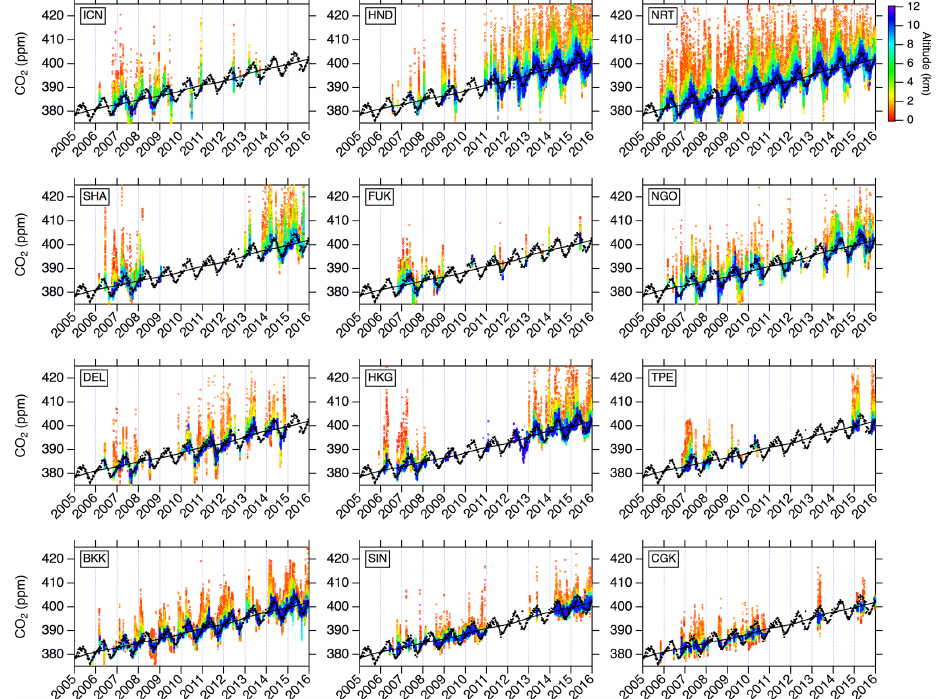
Figure 2. Temporal variations in CO 2 over various airports in Asia. See Table 1 and Fig. 1 for the airport codes. Individual CO 2 data points are colored by altitude. The CO 2 data over the two Shanghai airports (SHA and PVG) are merged and designated as SHA, and same for ICN (ICN and GMP) and TPE (TPE and TSA). Also shown in each panel for comparison are the flask-based CO 2 data (black circles) and the long-term trend (black line) at the Mauna Loa Observatory (MLO; 19.54 ◦ N, 155.58 ◦ W; 3397m above sea level; data obtained from the